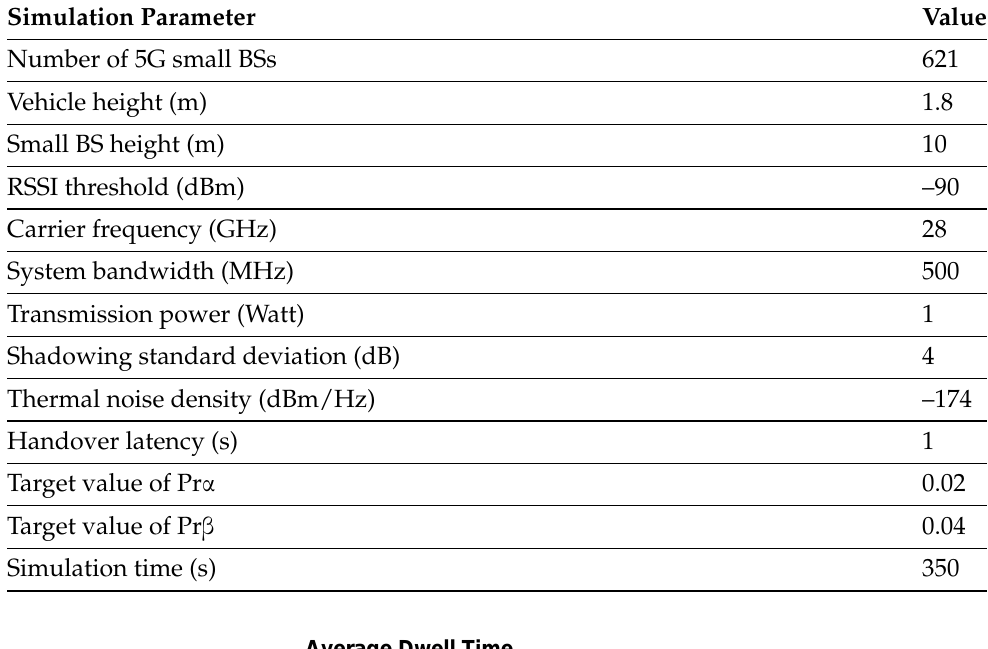
Table 7. Simulation parameters.